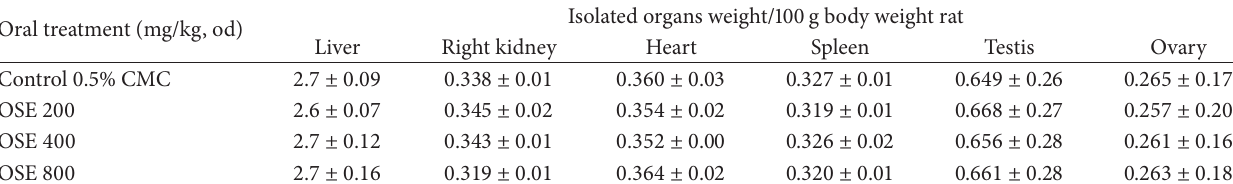
Table 4: Effect on isolated organs weight after 28 days of the oral administration of OSE.